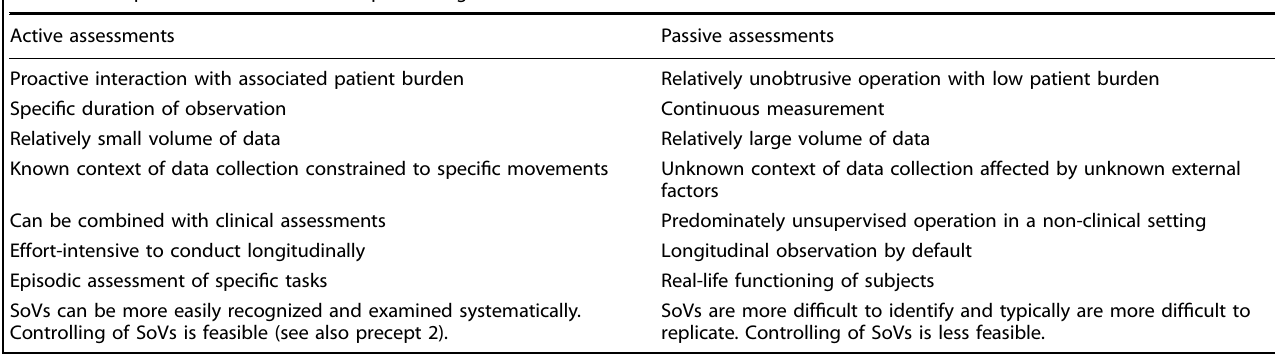
Table 1. Comparison between active vs. passive digital